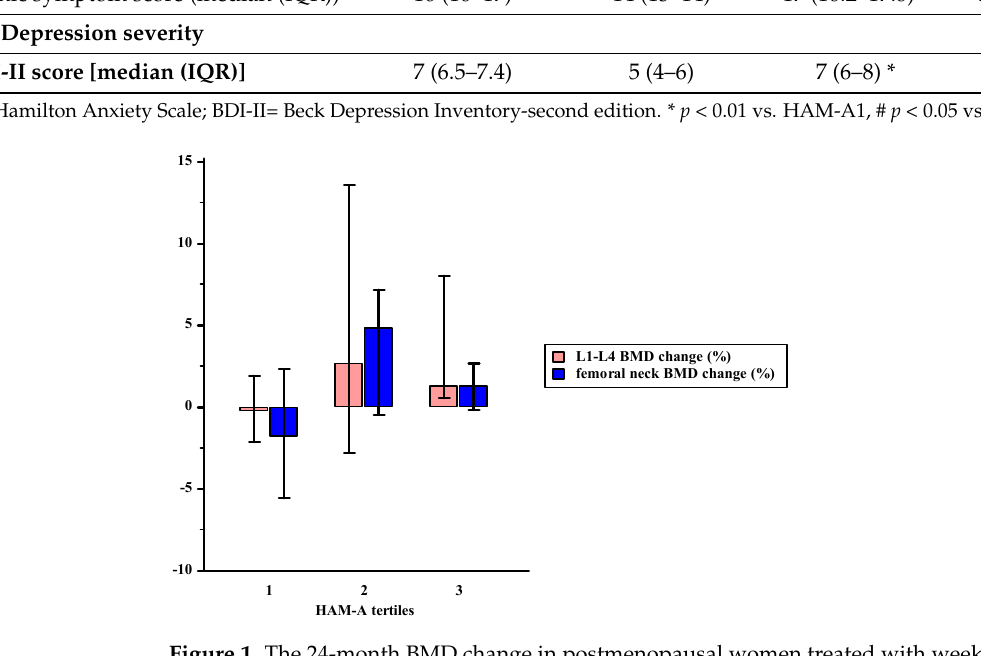
Figure 1. The 24-month BMD change in postmenopausal women treated with weekly alendronate or risedronate, according to tertiles of anxiety levels (HAM-A 1 < HAM-A 2 < HAM-A 3). With specific regard to adherence versus alendronate or risedronate, it was >75% in 68% of patients with lower anxiety levels (HAM-A 1), in 79% of patients with middle anxiety levels (HAM-A 2), and in 89% of patients with higher anxiety levels (HAM-A 3) ( p = 0.0014) (Figure 2). Conversely, no significant difference was found with reference to adherence versus vitamin D, since adherence was >75% in 88% of patients in the HAM-A 1, in 94% of patients in the HAM-A 2, and in 95% of patients in the HAM-A 3 ( p > 0.05). During the follow-up, neither treatment-related adverse events nor incidents of diseases were reported in the study sample. The multiple regression analysis, selecting lumbar BMD change as the dependent variable and correcting for age, BMI, and the 10-yr. probability of osteoporotic fractures, showed that anxiety levels were independent predictors of lumbar BMD changes at 24 months ( β = 0.3417, SE 0.145, p = 0.02).